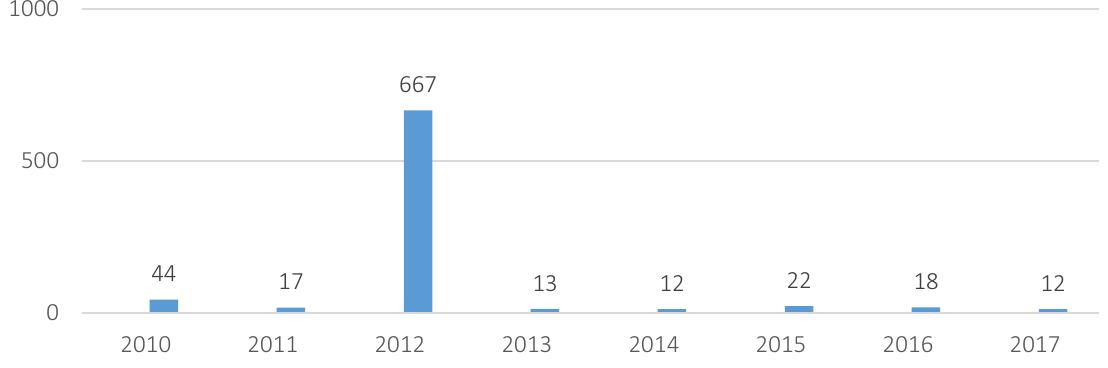
Figure 3. Number of complaints made by consumers on financial and insurance